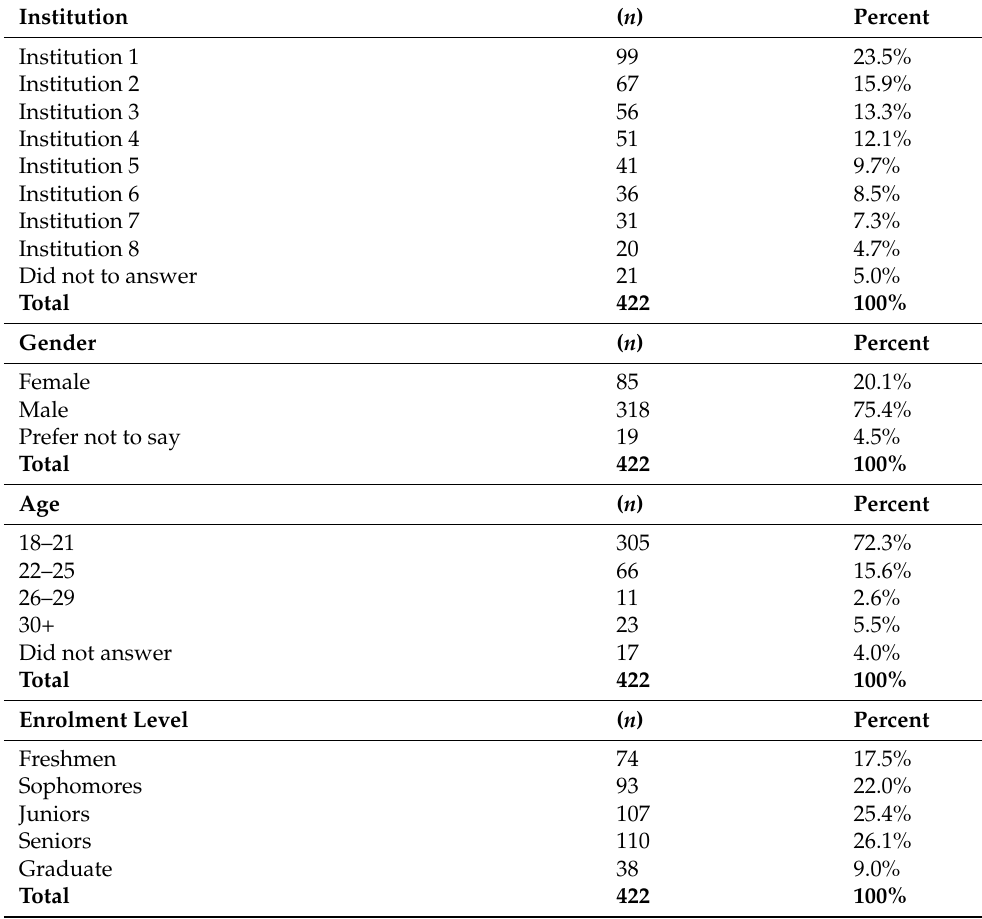
Table 1. Summary of Participant’s